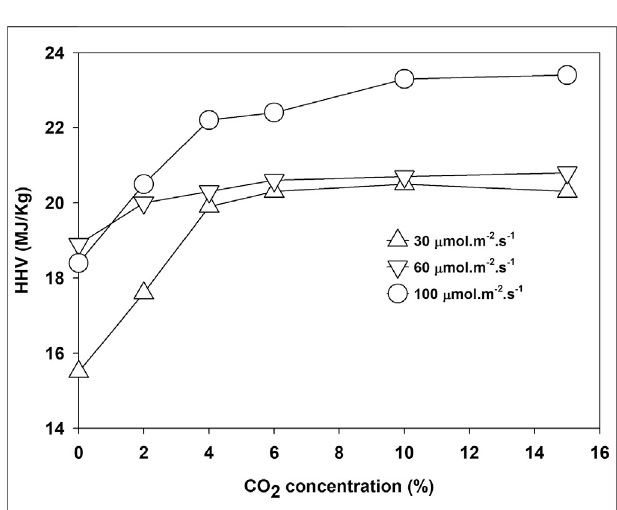
FIGURE 5 | The higher heating value of Parachlorella kessleri HY-6 at different light intensities and CO 2 concentrations.